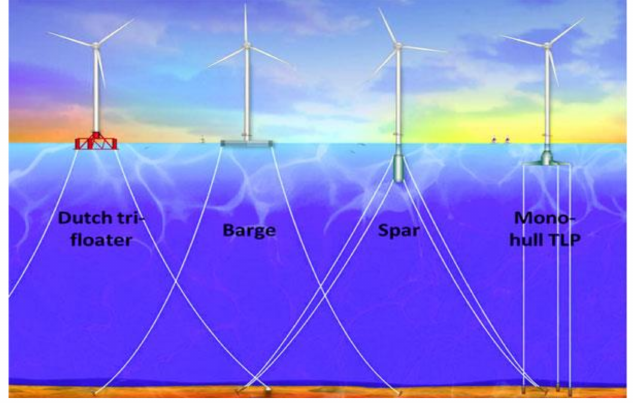
Figure 3. Types of floating wind turbine platforms; Reprint with permission [13]; 2007,